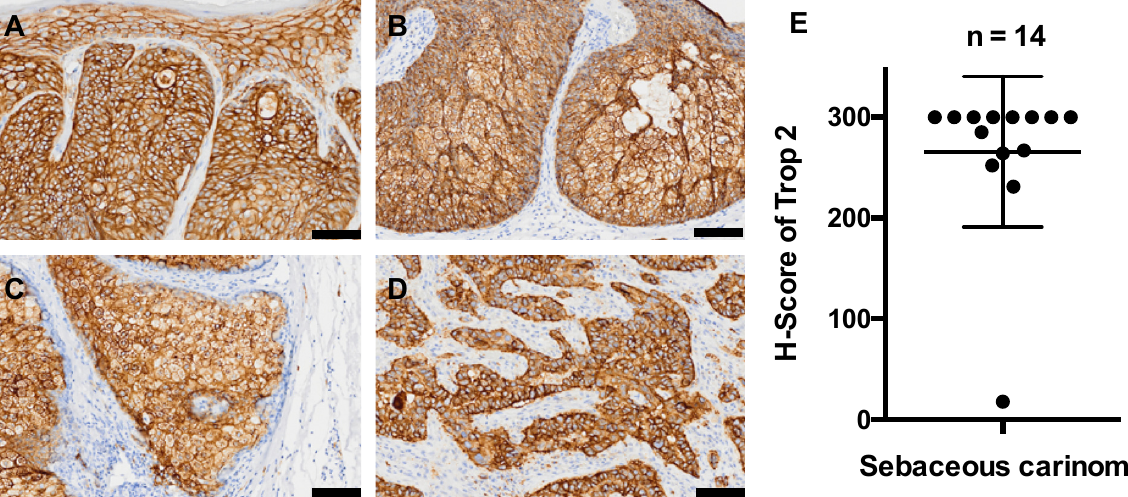
Figure 2. Histopathological images of trophoblast cell surface antigen 2 (TROP2) staining in sebaceous carcinoma. ( A – D ) Positive TROP2 signals were found on the membranes and in the cytoplasm of tumor cells. ( E ) The H-scores of TROP2 in all 14 sebaceous carcinoma samples. Bars indicate 100 µ m.